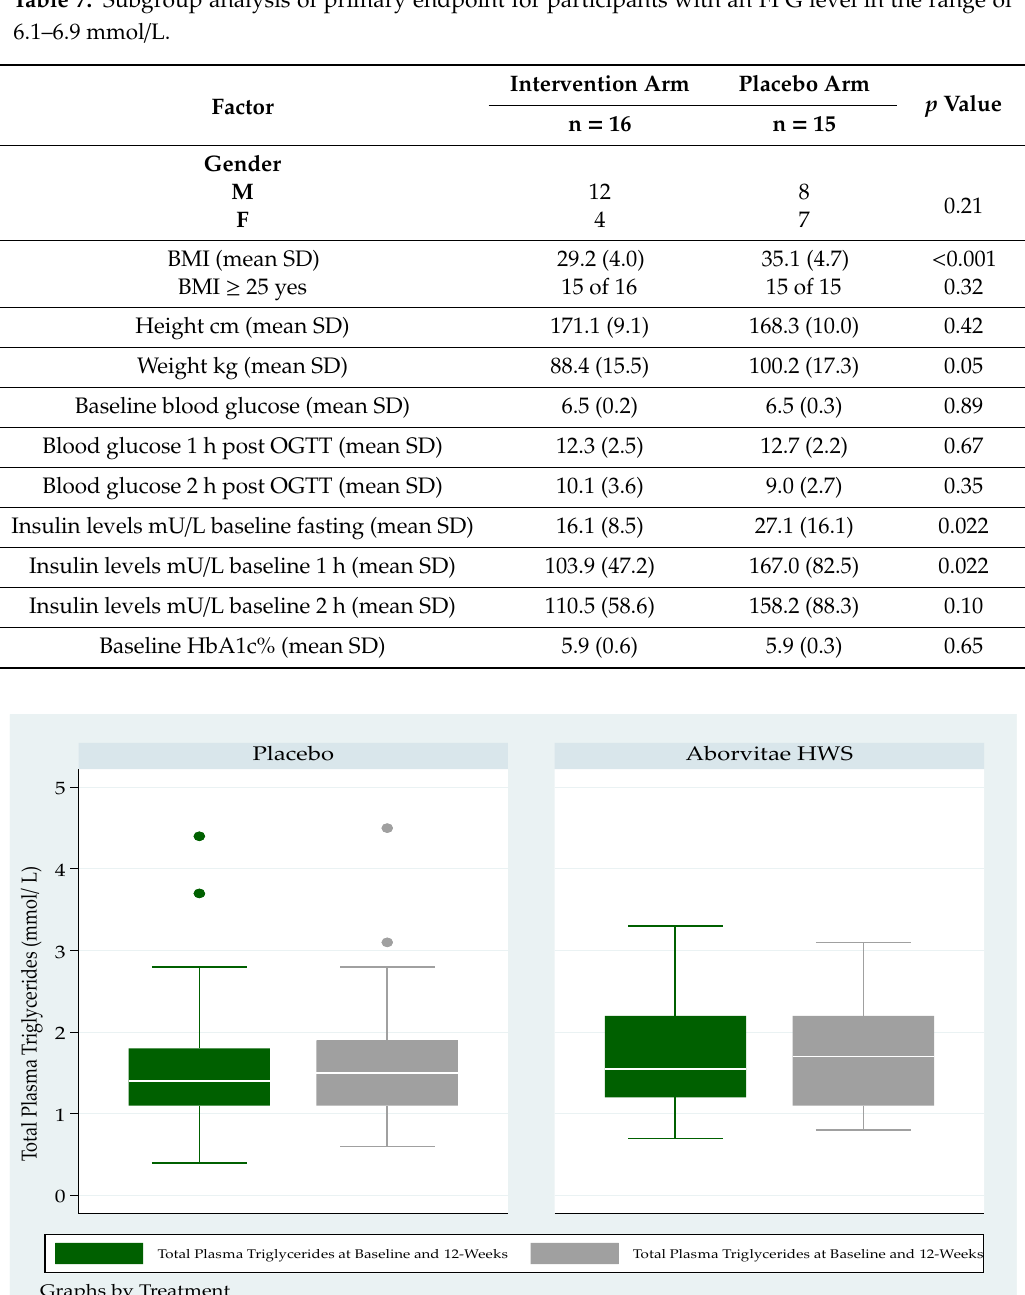
Figure 4. Total plasma triglycerides (mmol/L) at baseline and at the end of the study (12-weeks) ( p > 0.05).